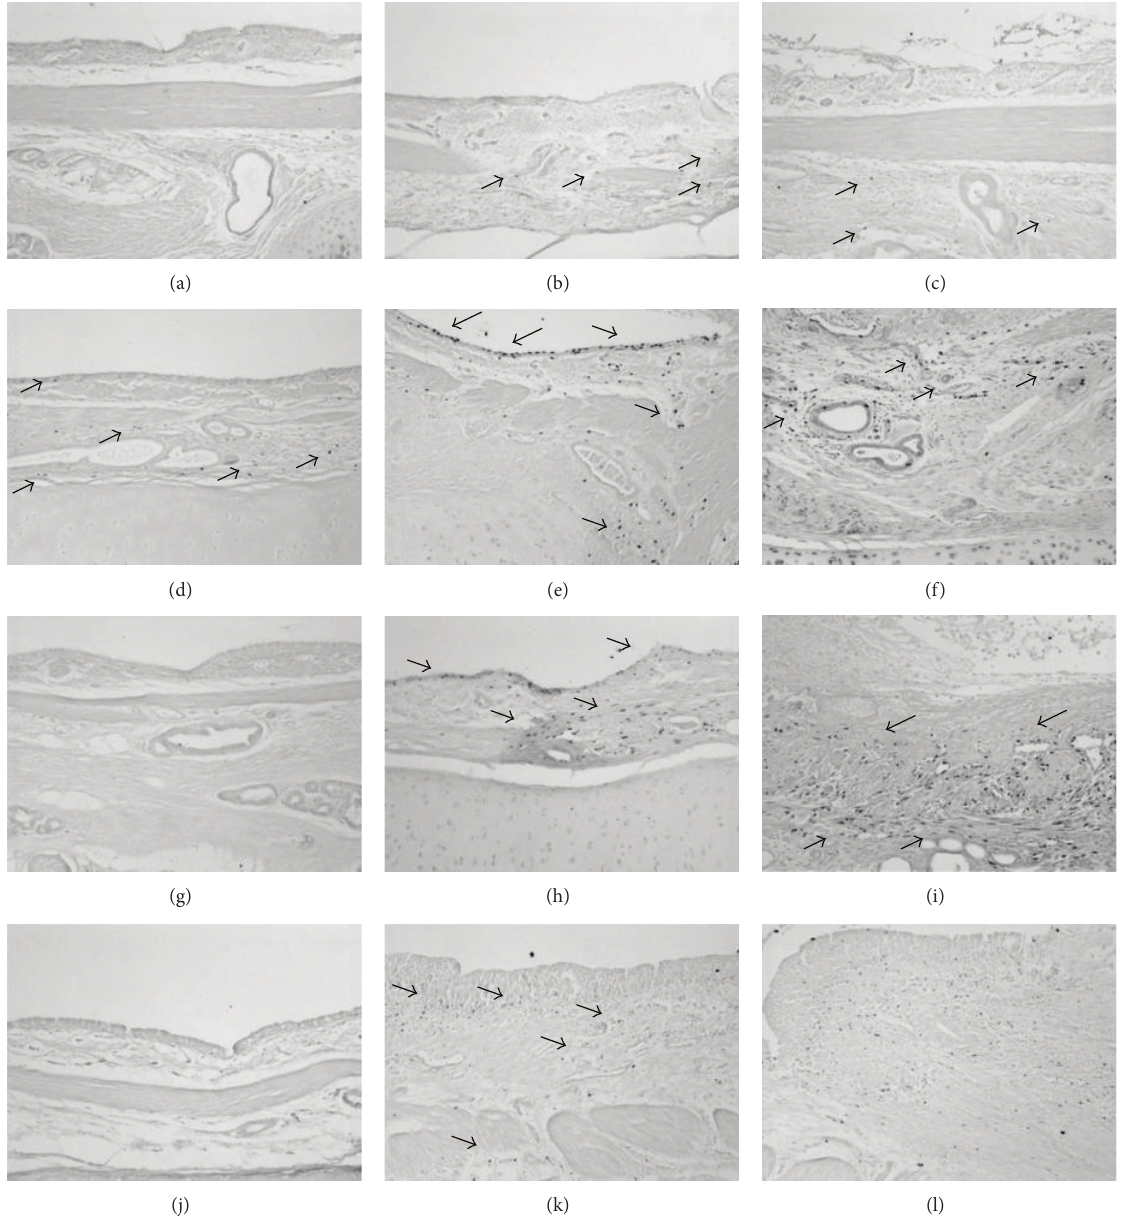
Figure 1: Airway tissue sections stained with BrdU. Histological images ( × 10) of airway wall sections from airways undergoing repair 6 hours ((a)–(c)), 1 day ((d)–(f)), 3 days ((g)–(i)), and 7 days ((j)–(l)) after physical injury induced by bronchial brush biopsy. The leftmost column depicts the undamaged airway wall opposite the site of injury, the middle column: the transitional zone between that area, and the area directly damaged by the brush biopsy in the rightmost column. No increase in proliferative activity was apparent 6 hours after physical injury ((a)–(c)). By day 1, there was a noticeable increase in the proliferative activity in the epithelium of the transitional zone bordering the lesion (e) as well as in the mucosa and submucosa underlying the area of damage (f). By day 3, there was still evidence of cell proliferation in both the lesion margins (h) as well as in the organising matrix of the damaged wall (i). By day 7, the extent of proliferation had started to decline in both areas ((k),